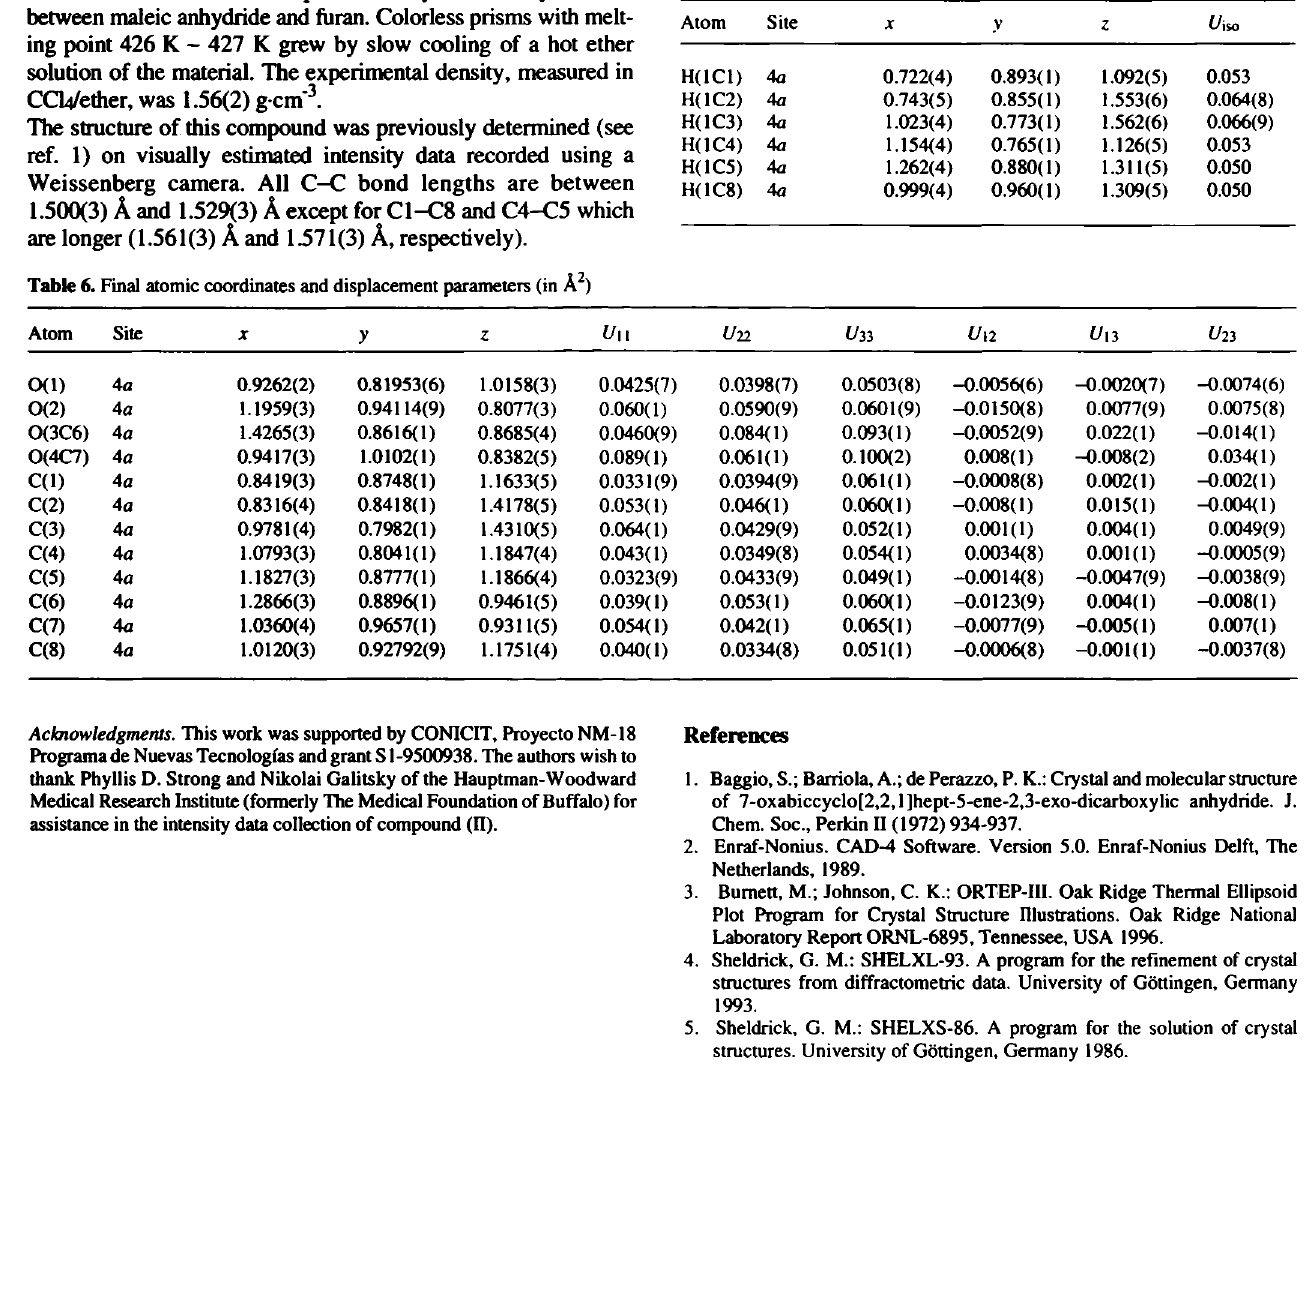
Table 5. Final atomic coordinates and displacement parameters (in